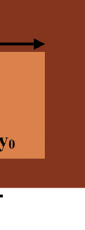
Figure 4. Electric field intensity of the center diagram in ρ -direction with different bending angles: ( a ) 0°, ( b ) 10°, ( c ) 20°, and ( d ) 35°.